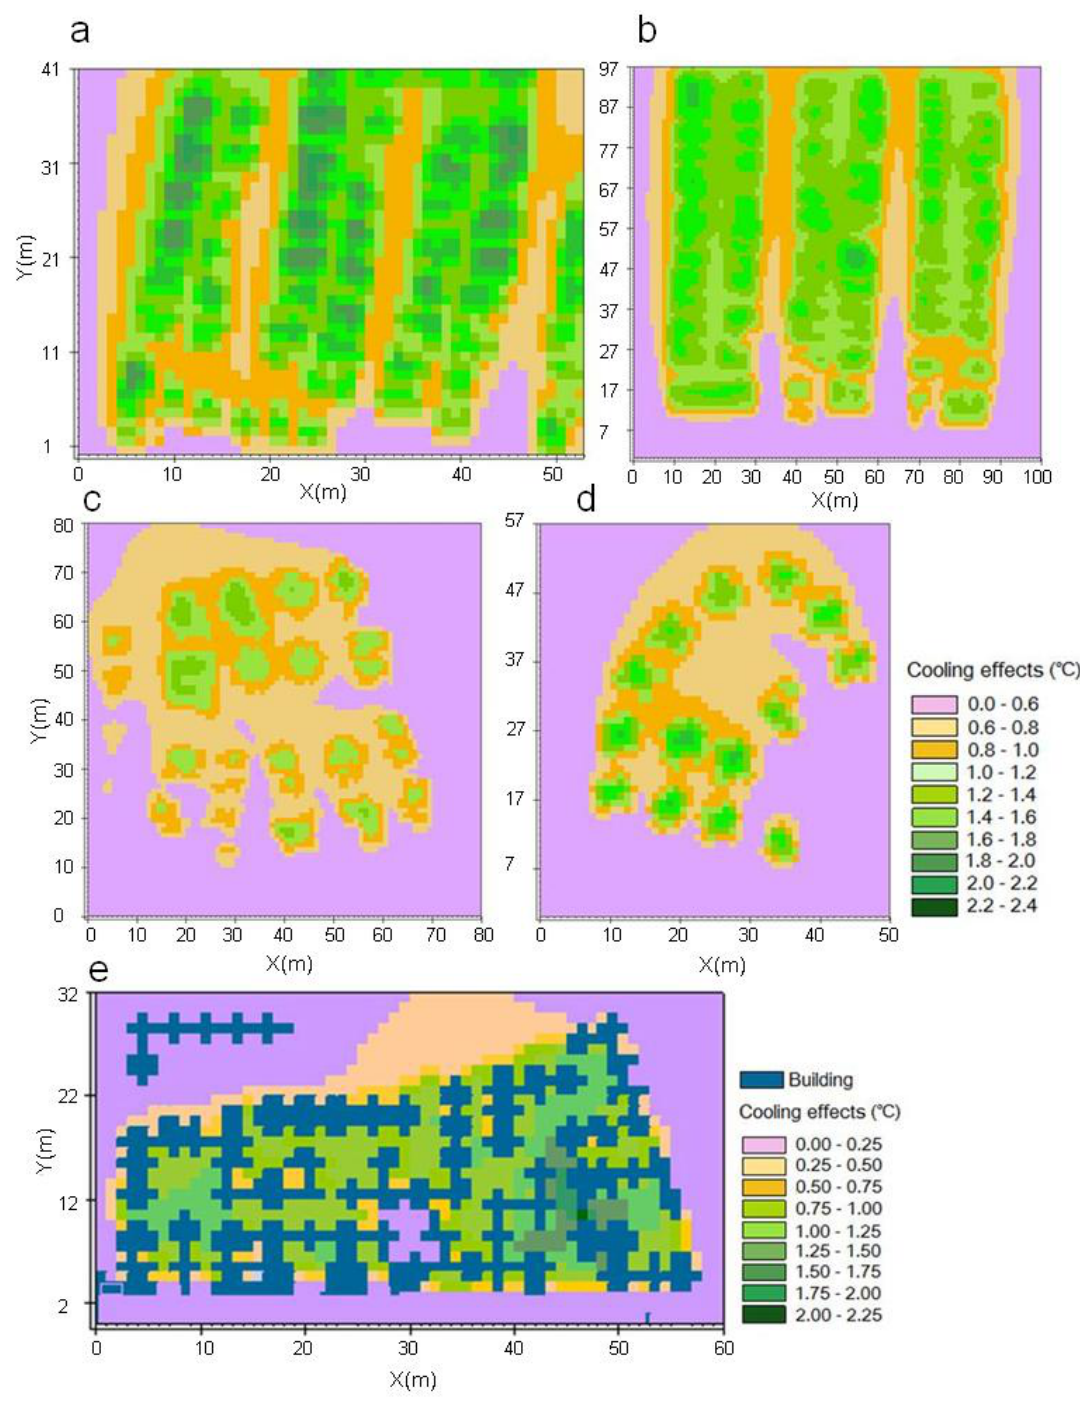
Figure 6. Horizontal distribution of cooling effects for intensive green roof (IGR) at the rooftop-podium level at 14:00 (cooling effects refer to the air-temperature differences between the bare and green-roof scenarios). ( a ) KT; ( b ) KC; ( c ) BC; ( d ) CM; ( e )